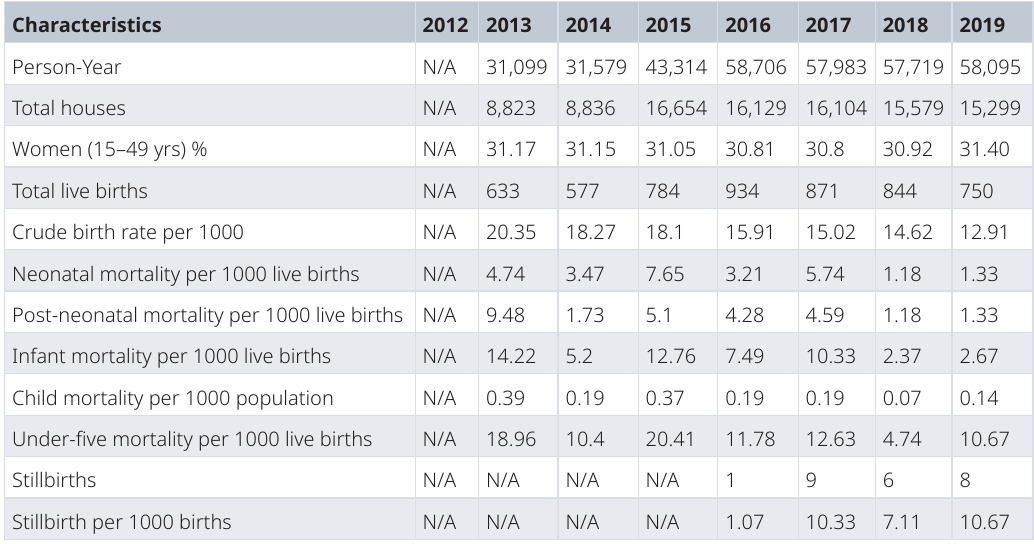
Table 2. Harar HDSS